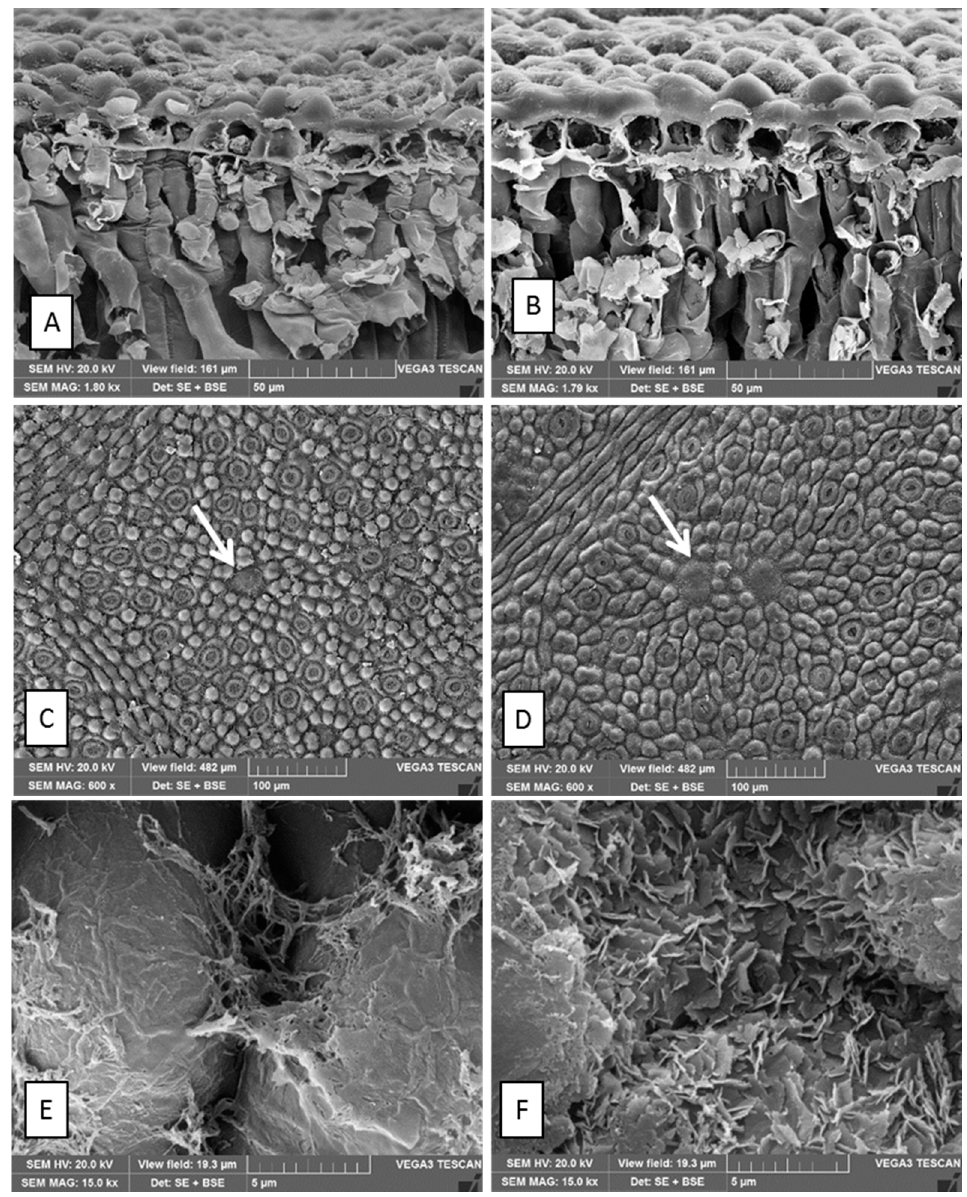
Figure 3. SEM images ( A , C , E — E. cinerea and B , D , F — E. nicholii ): ( A , B ) leaf transversal section showing papillae on the adaxial surface and ( C , D ) adaxial surfaces. White arrows show the overlying cells covering the secretory cavities. ( E , F ) tubular waxes in EC and crystalloid waxes (rosettes) in EN.